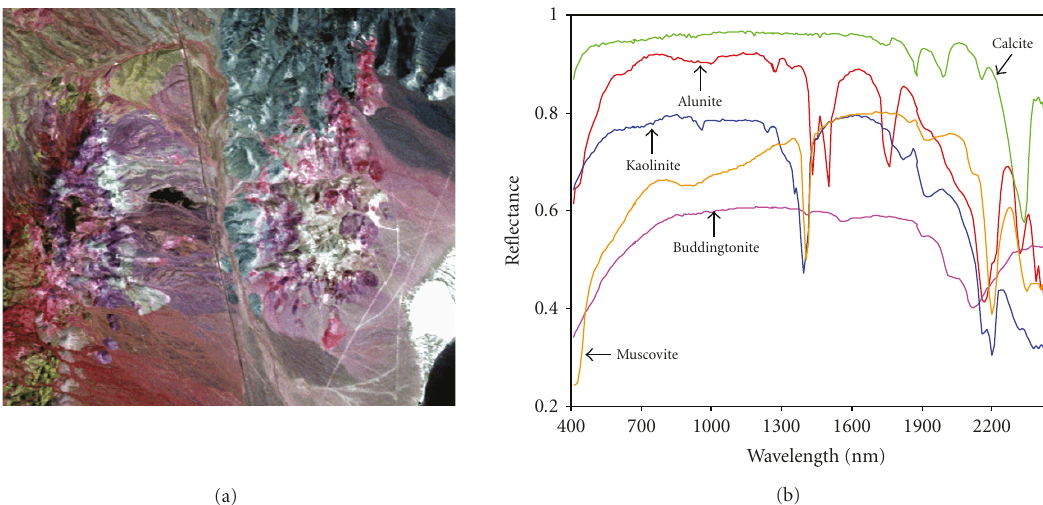
Figure 10: (a) False color composition of the AVIRIS hyperspectral over the Cuprite mining district in Nevada. (b) US Geological Survey mineral spectral signatures used for validation purposes.